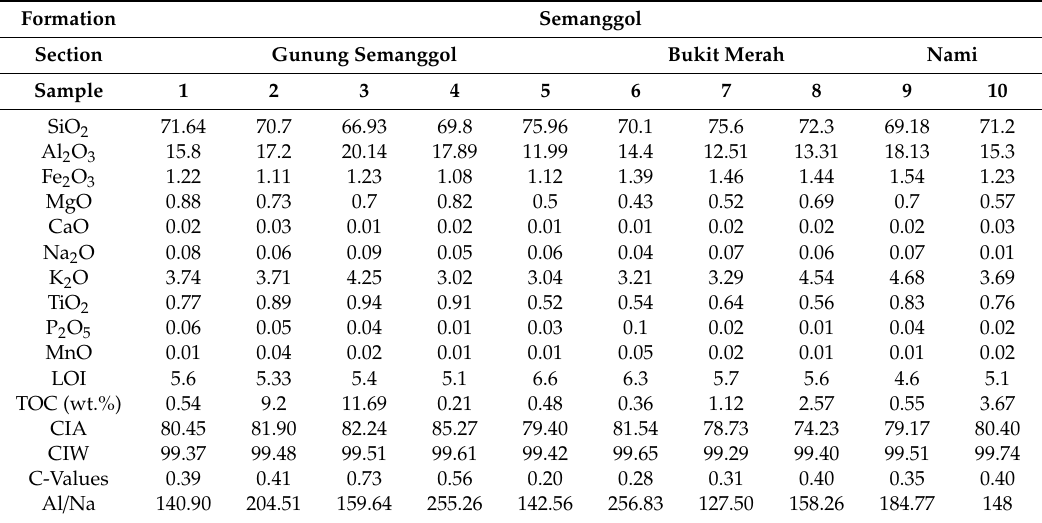
Table 3. Major oxide concentrations and geochemical anomalies (CIA, CIW and C-value) of black shale from the Semanggol